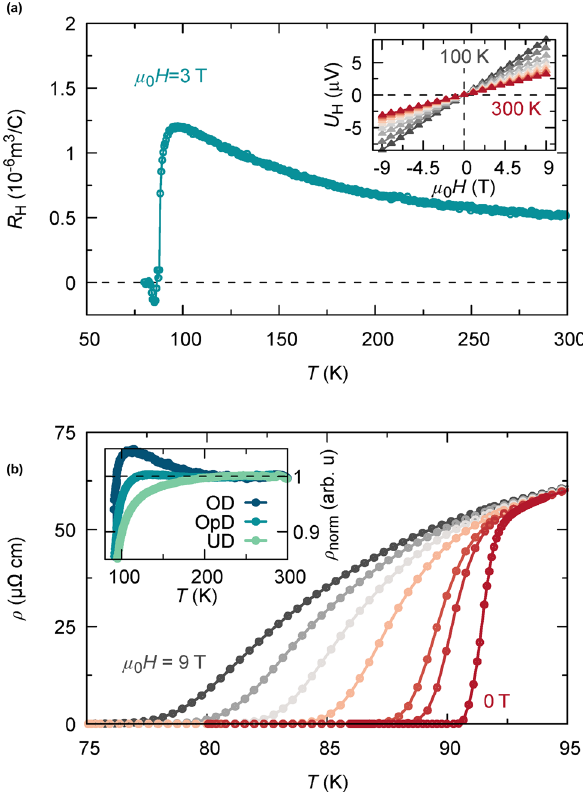
Figure 1. Electrical analysis of YBCO thin films. ( a ) Hall constant R H obtained at 3 T as a function of temperature. R H is perfectly linear within the analysed field range (− 9 to 9 T) and vanishes in zero field condition at all T as shown in the inset. Charge carrier density is obtained via Hall effect measurements using 1 ρ( T , H ) , as a function of temperature at different magnetic fields n H ( T ) R H ( T ) q . ( b ) In-plane resistivity, = c ) to evaluate the field dependent superconducting transition temperature, T 0 ( H ) . (0, 0.5, 1, 3, 5, 7, 9 T, H (cid:31) (ρ( T ) ρ 0 )/ bT , where b is the linear slope at high temperatures Inset shows normalized resistivity, ρ norm = − ( T > 150K ) . Doping dependent deviation from unity is observed, as shown for an underdoped (UD, downwards deviation), optimally doped (OpD) and overdoped (OD, upwards bending) 200 nm thick YBCO film,